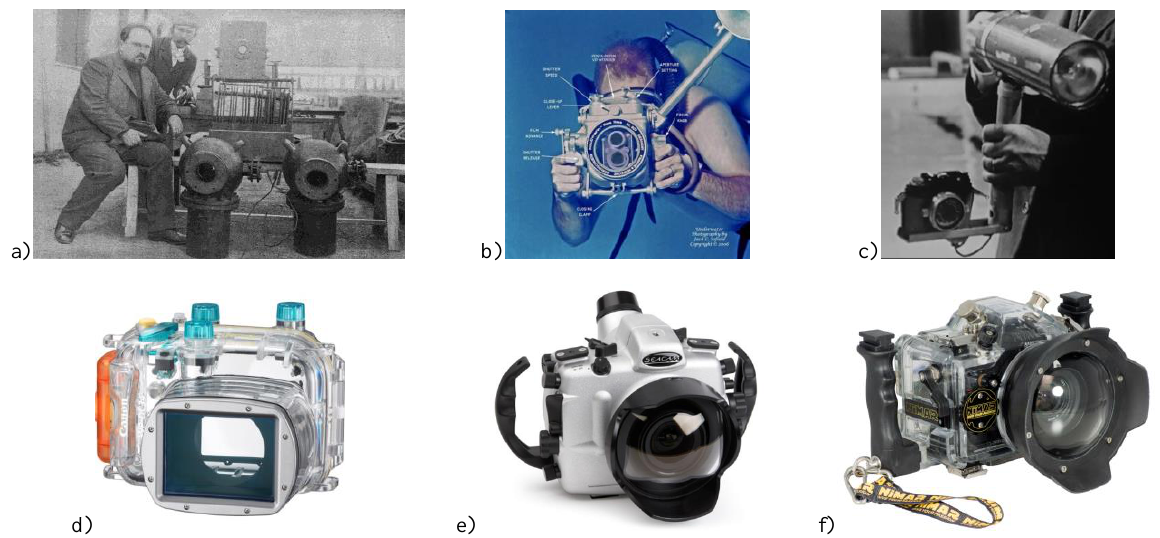
Figure 5. (a) Boutan’s underwater camera (Fadedanblurred). (b) Rolleimarin underwater housing with flash (Pbase). (c) Nikonos Calypso camera with underwater electronic flash (frames extracted from EDC). (d-e-f) Waterproof housings for digital cameras; from left to right: Canon with flat port for compact cameras, Seacam and NiMAR with dome port for DSLR cameras.